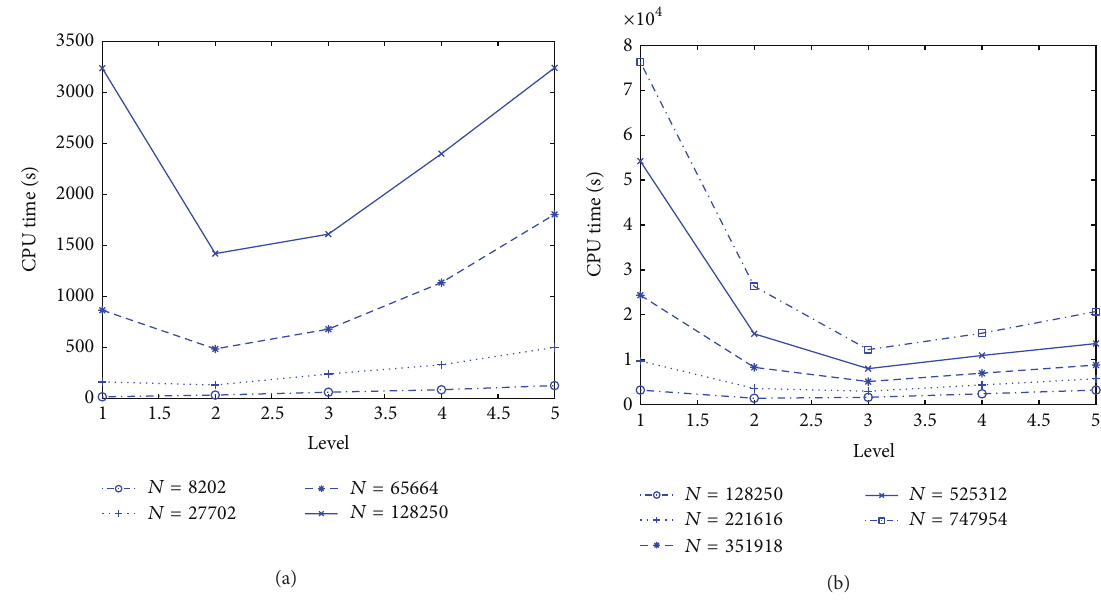
Figure 8: CPU time versus the level number for different collocation points 𝑁 𝑐 .